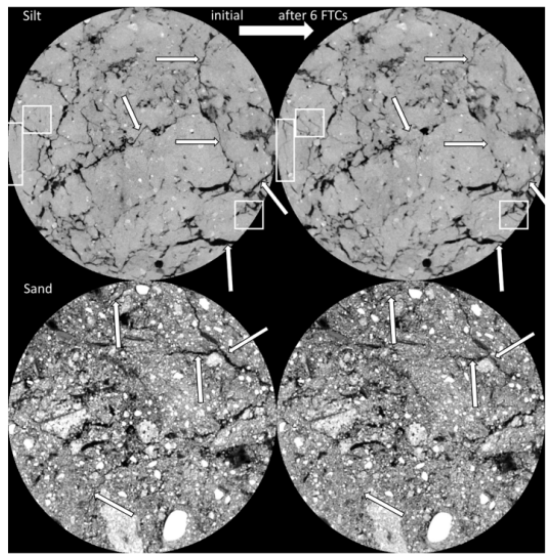
Figure 2. Horizontal cross-section through four greyscale images. Note: The upper two are images of the more compacted lower regions of a silt sample before the first FTC ( left ) and after six FTCs ( right ). The lower images show the same for a sand sample. Arrows show pores which became thinner and rectangles show where new voids occurred [58]. Table 1. Researches of the effect of freeze-thaw on soil